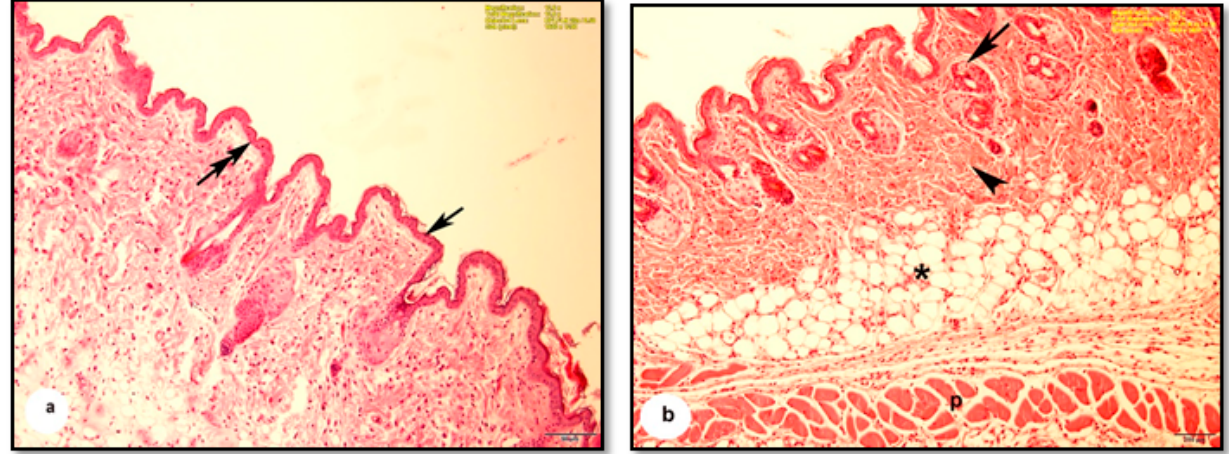
Figure 3. Photomicrographs of sections of normal mice skin before burning. ( a ) Showing the folded epidermis (arrow) based on the basement membrane (double-head arrow). ( b ) Showing the dermis (arrowhead) containing many hair follicles (arrow), bundles of fat cells forming adipose tissue arranged in lobules separated by septa of connective tissue (*), panniculus carnosus muscle (P) (H & E, scale bar: a = 100 µm, b = 100 µm).